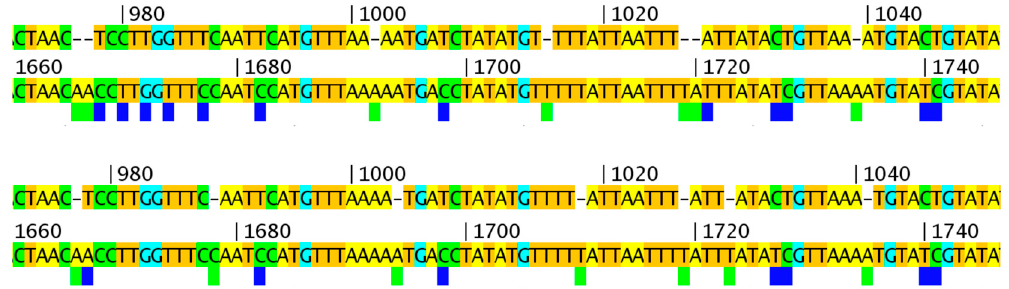
Figure 3. Optimization of alignments with multiple small gaps. Upper/lower panels: top sequence: VARV-India-1967, bottom sequence: VARV consensus. Top panel: MAFFT global genome alignment with default parameters. Bottom panel: manually corrected alignment with reduced SNPs. The blue and green boxes indicate SNPs and gaps in the VARV-India-1967 sequences, respectively. Numbers refer to position in 98 kb alignment.